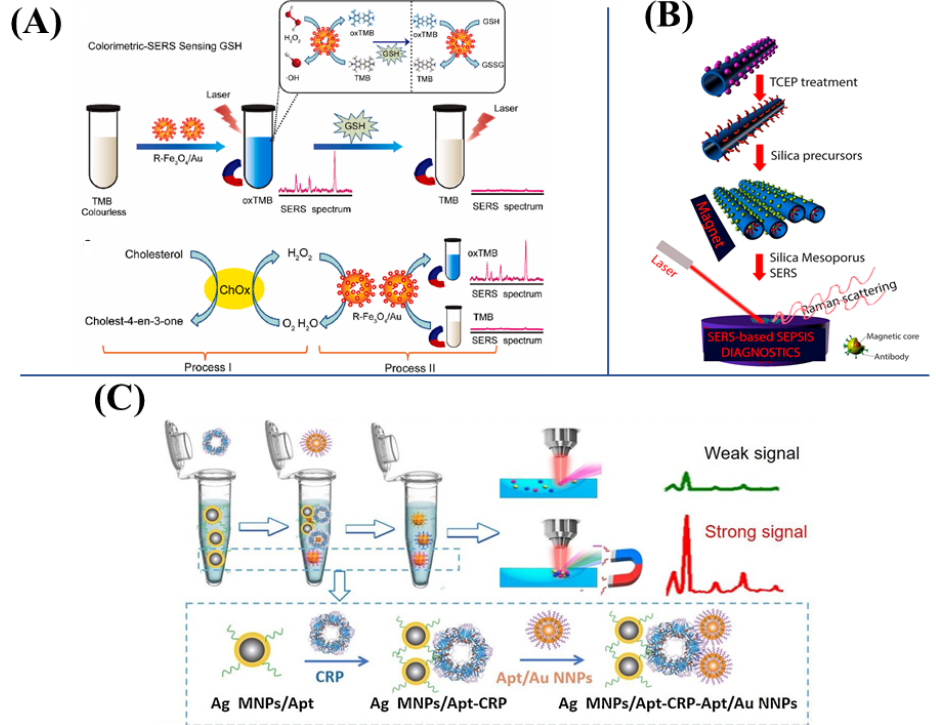
Figure 5. ( A ) The SERS-FL dual-mode detection of GSH and cholesterol based on R–Fe 3 O 4 /Au. Reproduced with permission from Ref. [112]. Copyright 2022, Elsevier. ( B ) The SERS-based triplex assay using Au-coated magnetic NCs for sepsis diagnostics. Reproduced with permission from Ref. [120]. Copyright 2016, Elsevier. ( C ) The illustration of protein detection via Ag MNPs–CRP–Au NNPs “sandwich” structure by SERS. Reproduced with permission from Ref. [121]. Copyright 2021, Elsevier.